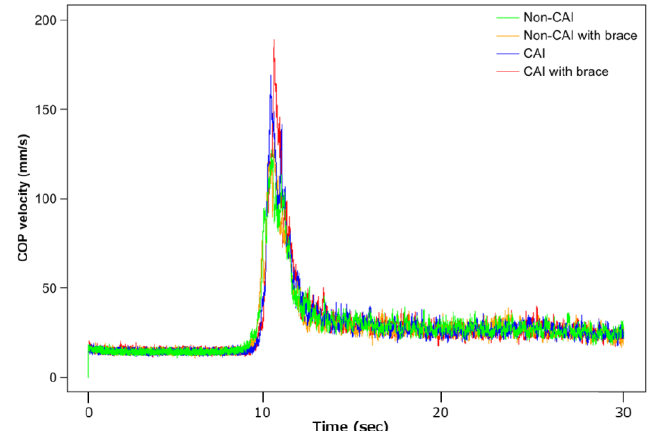
Figure 4. Graph showing the amount of change in center of pressure (COP) velocity from DLS to SLS. The horizontal axis indicates DLS and SLS, and the vertical axis indicates COP velocity. There was a signi fi cantly higher score in the CAI group with knee brace than in non-CAI group and the CAI group without knee brace ( p < 0.01).